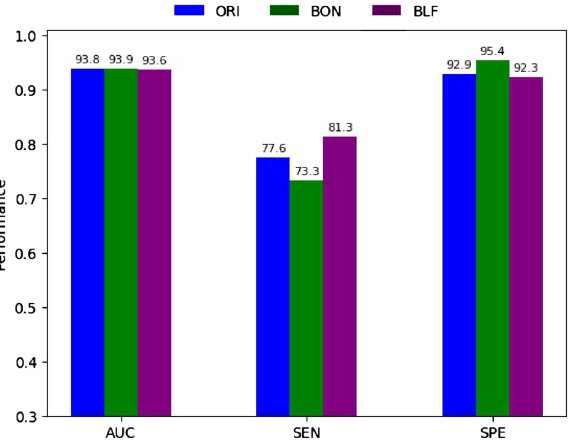
Figure 6. Performance evaluated of three best models of ORI, BON, and BLF over Test-10 dataset using a prediction threshold of 0.5.